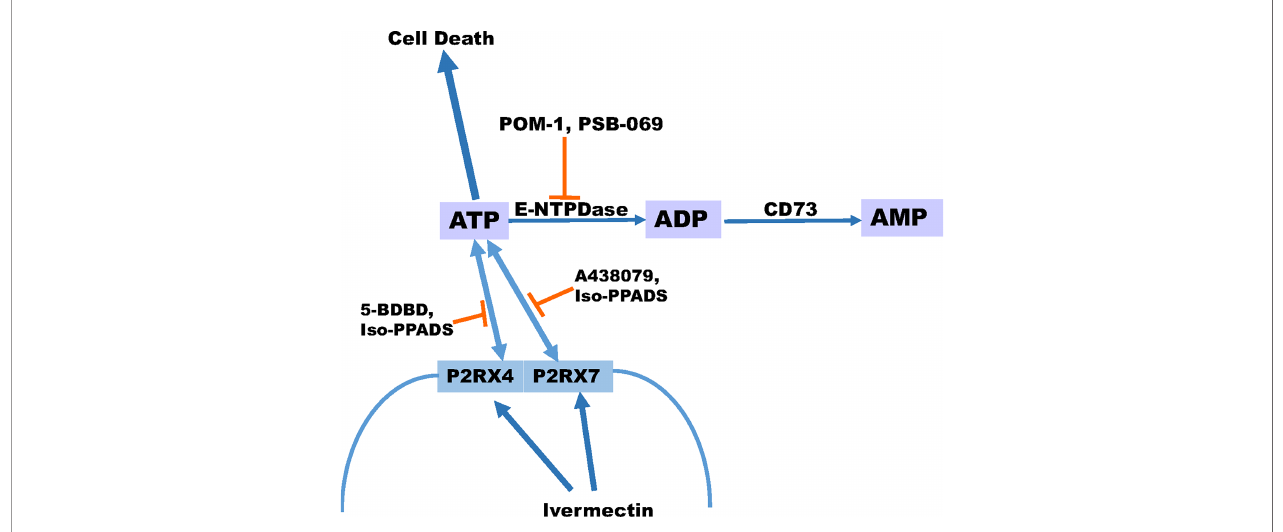
FIGURE 7 | Schematic displaying our proposed model for ATP release. Our proposed model suggests that ivermectin activates P2RX4 and P2RX7 leading to the release of ATP and the more ATP that accumulates extracellular can promote cell death especially in the presence of paclitaxel. In addition, the breakdown of ATP can be prevented in the presence of E-NTPDase inhibitors POM-1 or PSB 069. However, the release of ATP can be prevented in the presence of P2RX4 inhibitors 5-BDBD or Iso-PPADS or P2RX7 inhibitors A438079 or